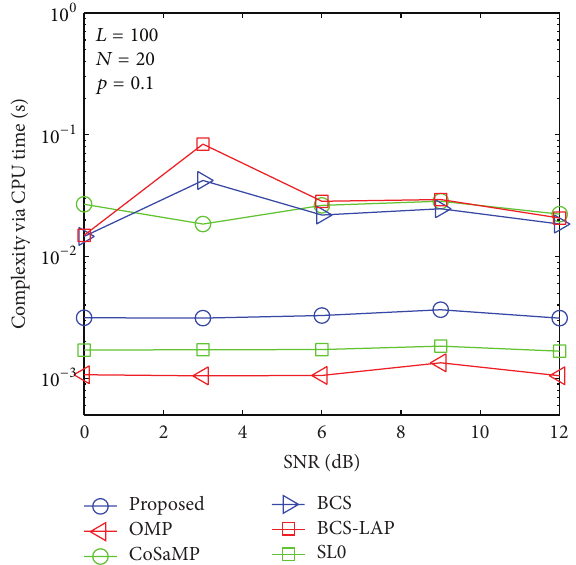
Figure11:AverageBERperformanceversusSNRwhen 𝑝 1 = 0.1 and 𝑁 = 40 .